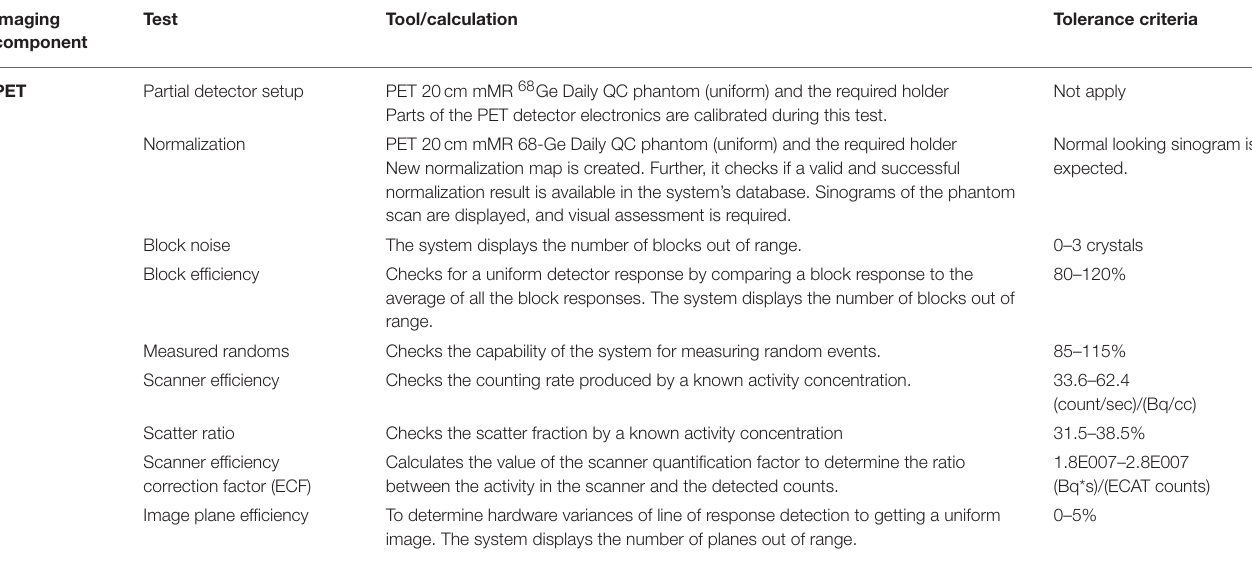
TABLE 4 | DQA tests for Siemens Biograph mMR PET/MR systems. Imaging